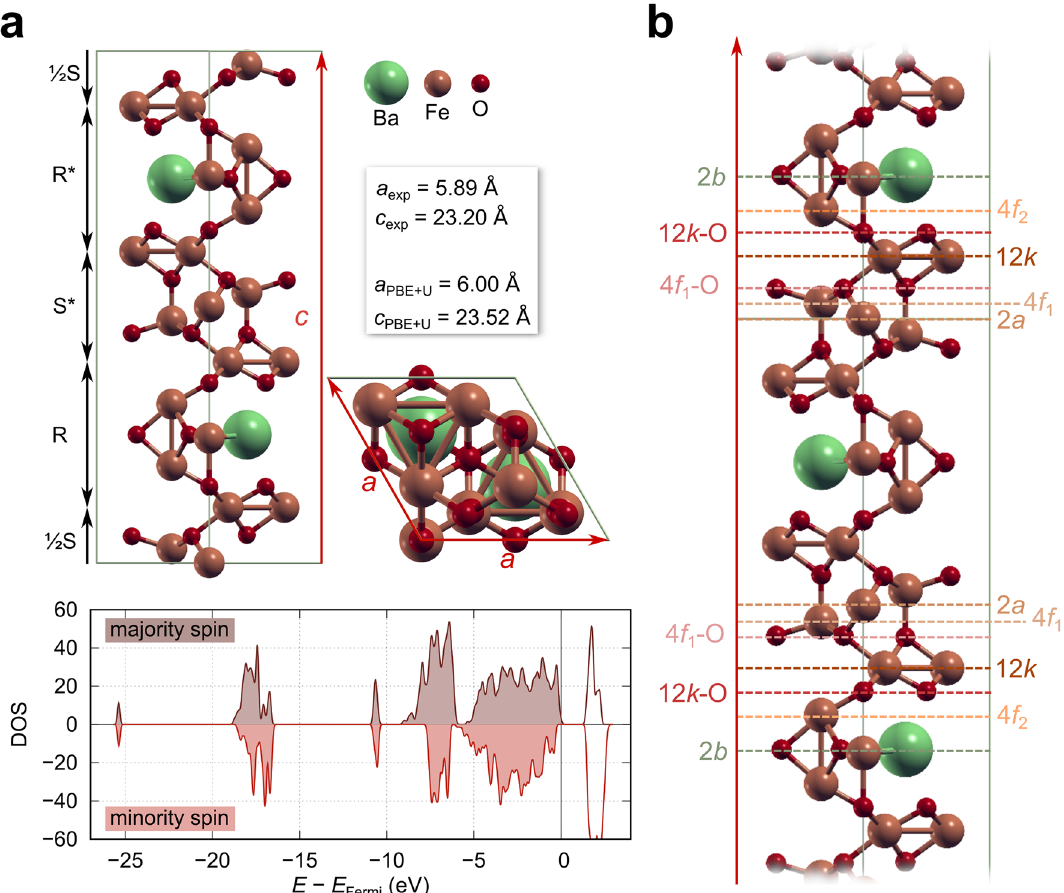
Figure 7. BHF-based systems ( a ) The top part shows the bulk structure of BHF and a comparison of experimental lattice parameters to those obtained with DFT + U. The bottom part shows the energy DOS obtained with spin-resolved DFT + U calculations. The two spin projections are represented in brown (majority spin) and red (minority spin), respectively and the occupied states are filled. The estimated bandgap is 1.4 eV, in line with the measured optical adsorption edge of 1.82–1.86 eV 38 . ( b ) The different bulk terminations of BHF bulk and their designations. The figure was generated by using inkscape 1.2.1 (https:// inksc ape. org/), gimp 2.10 (https:// www. gimp. org/), gnuplot 5.4 (http:// www. gnupl ot. info/), and xcrysden 1.6.2 41